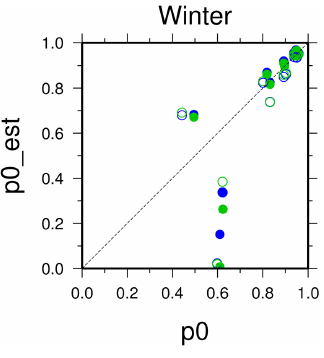
Fig. 8. Estimated probabilities of zero daily precipitation ( p 0 ). Dots (Circles): Validation-subset consists of all winter values with an even (odd) entry number. Blue symbols: First reanalysis data is in- terpolated to the test sites and then p 0 is calculated. Green symbols: p 0 is calculated at grid points and then interpolated.